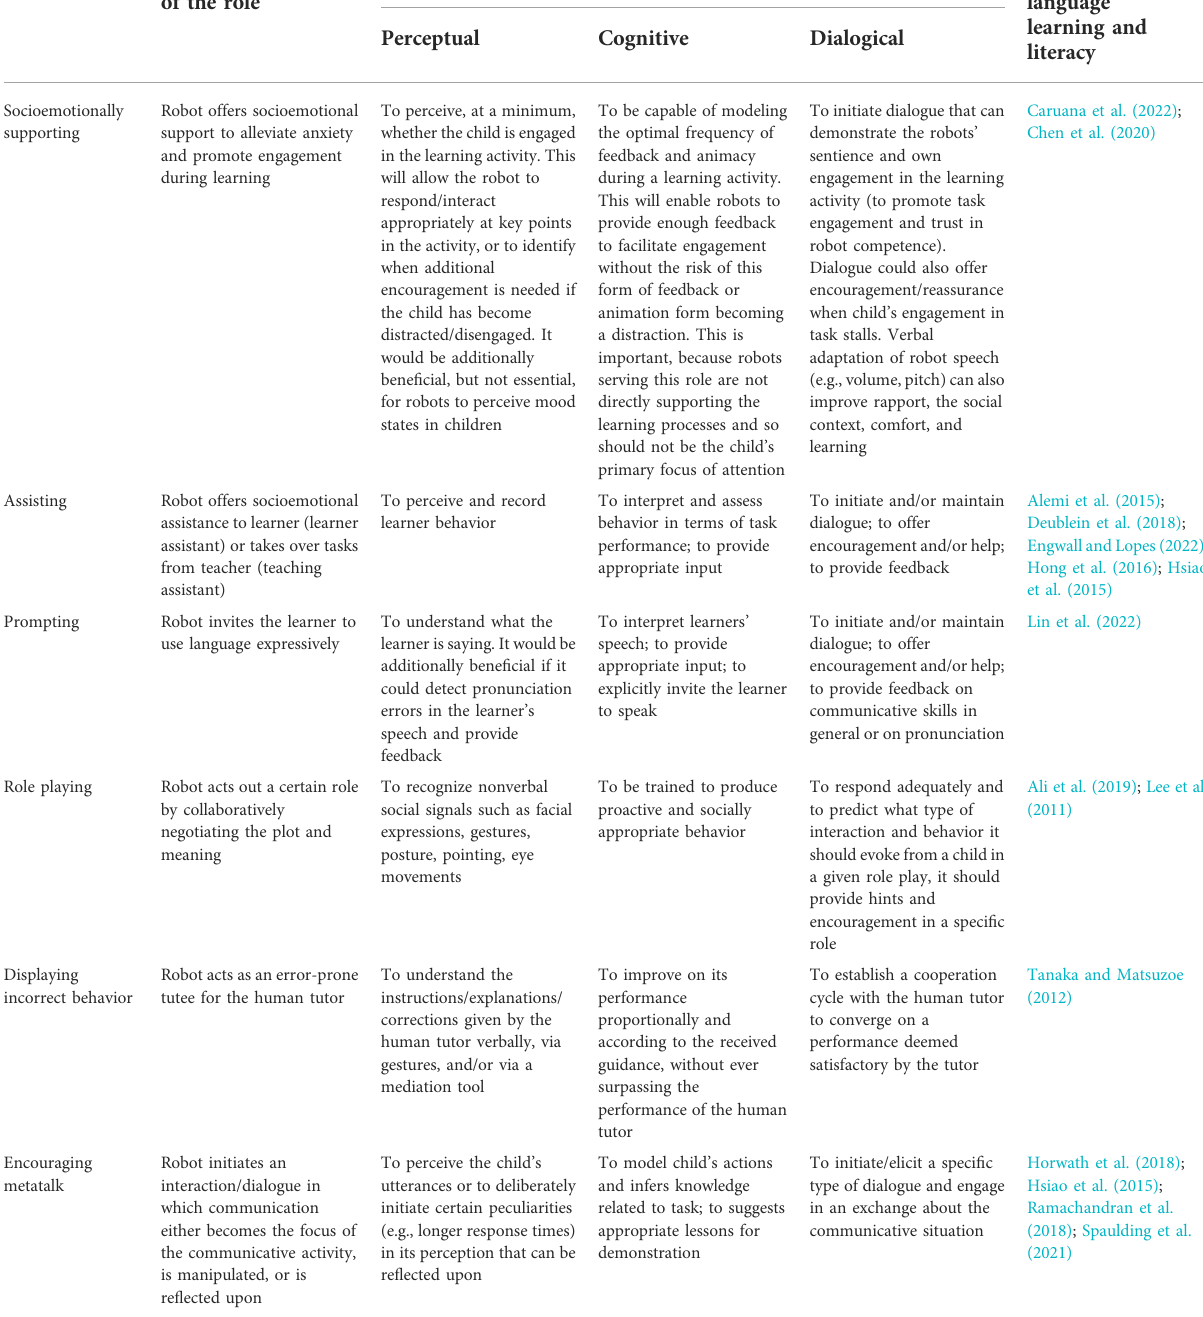
TABLE 1 De fi nition of innovative roles and references to the existing